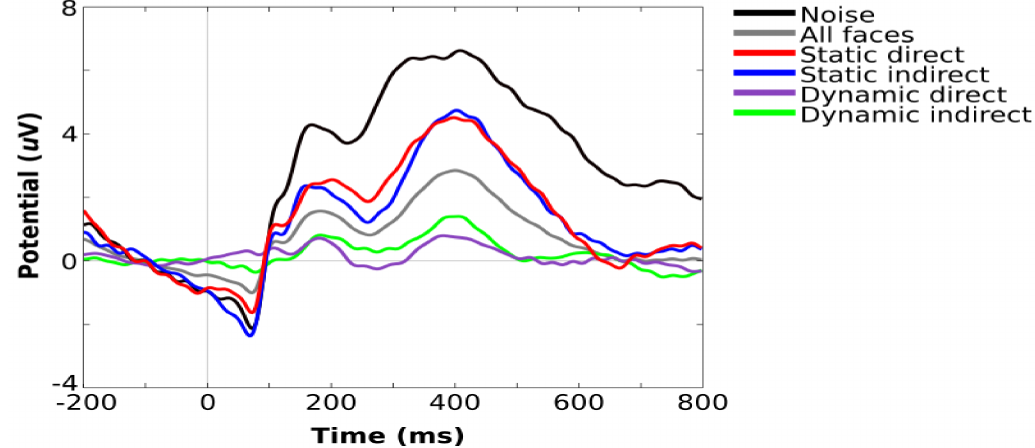
Figure 3. Grand average visual ERPs for all task conditions showing components typically observed during infant face processing, including P100, N290, and